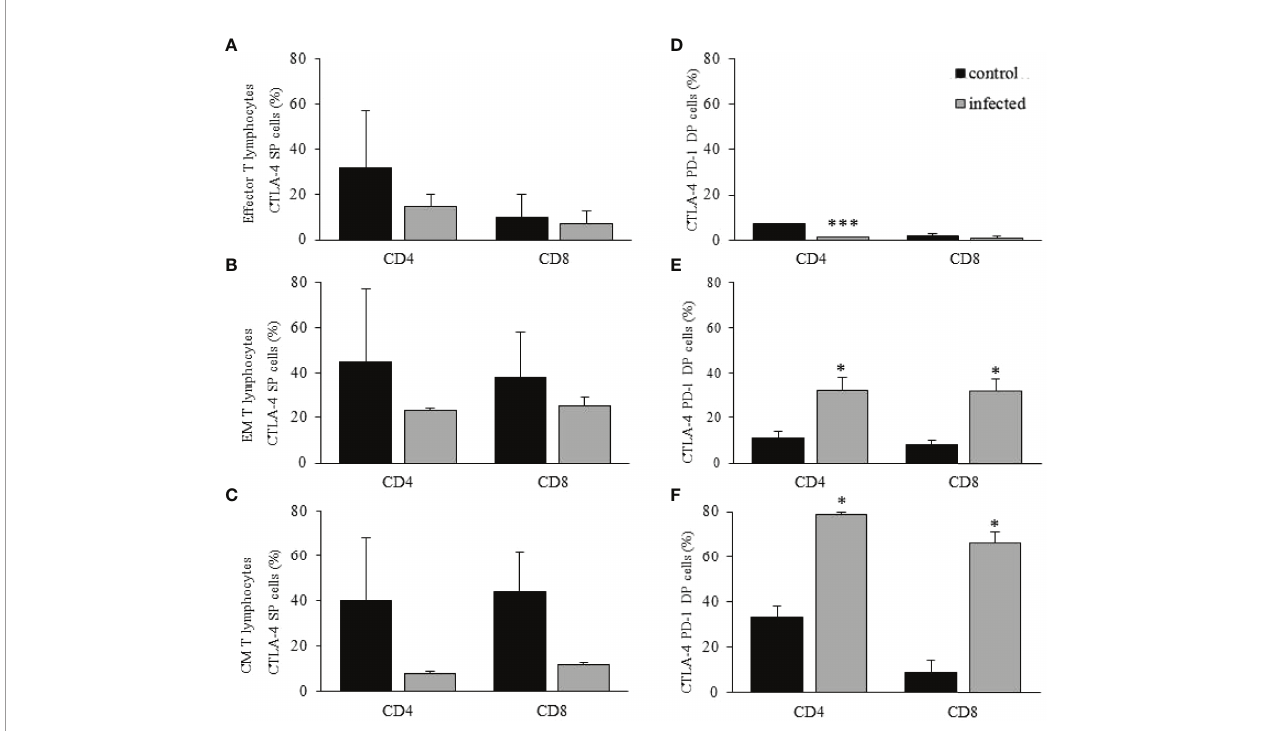
FIGURE 5 | Expression of immunoregulatory molecules on intrahepatic T lymphocytes. The analysis of CTLA-4 + single positive (A – C) or CTLA-4 + PD-1 + double- positive (DP) (D – F) cells is shown for CD4 + or CD8 + T intrahepatic lymphocytes. The cell frequency was evaluated in control and infected mice on dpi 15. * means p ≤ 0.05 and *** means p ≤ 0.001 using the one-way ANOVA test followed by Tukey ’ s